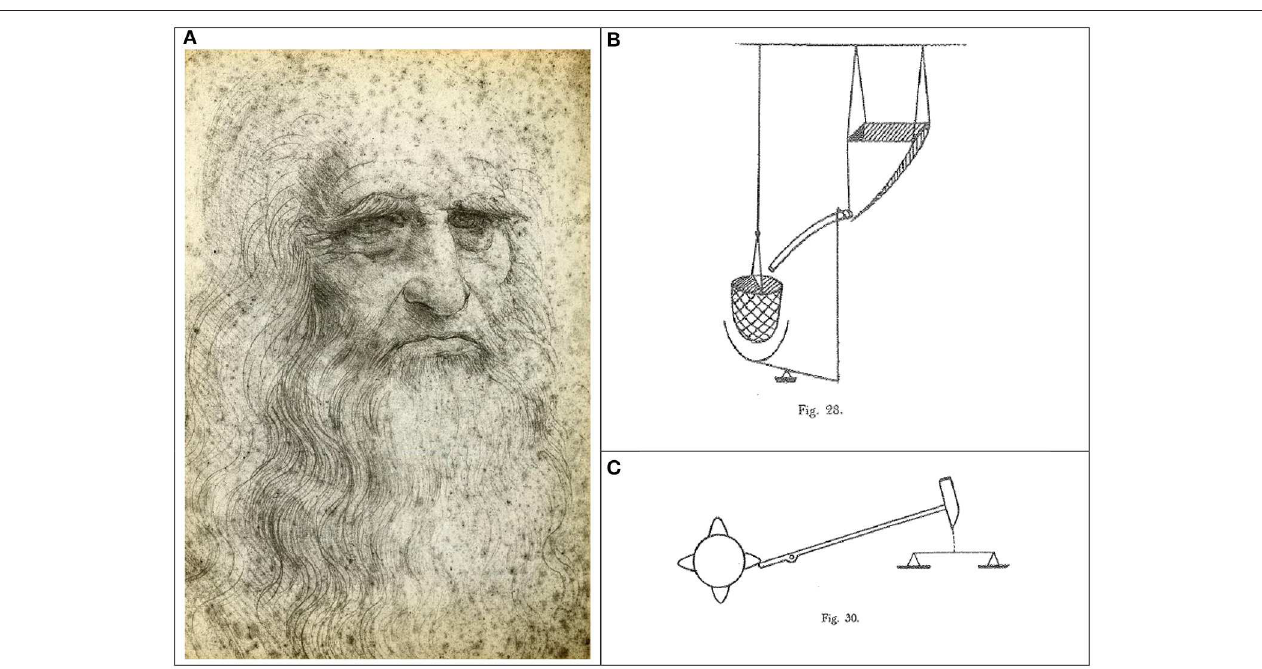
FIGURE 1 | (A) Leonardo da Vinci’s self portrait. (B) Tensile testing machine. (C) Impact testing